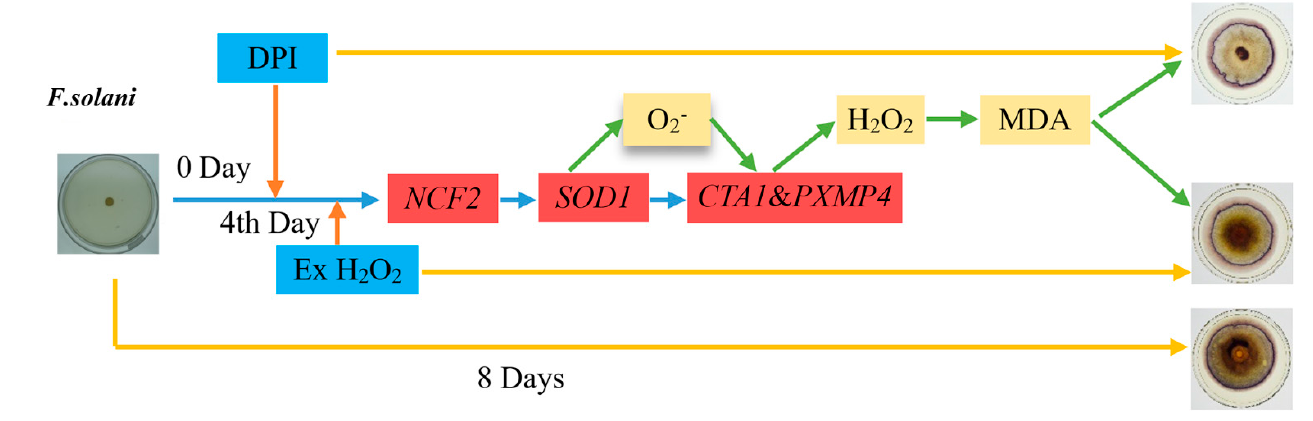
Figure 7. The mode diagram of ROS on F. solani growth.